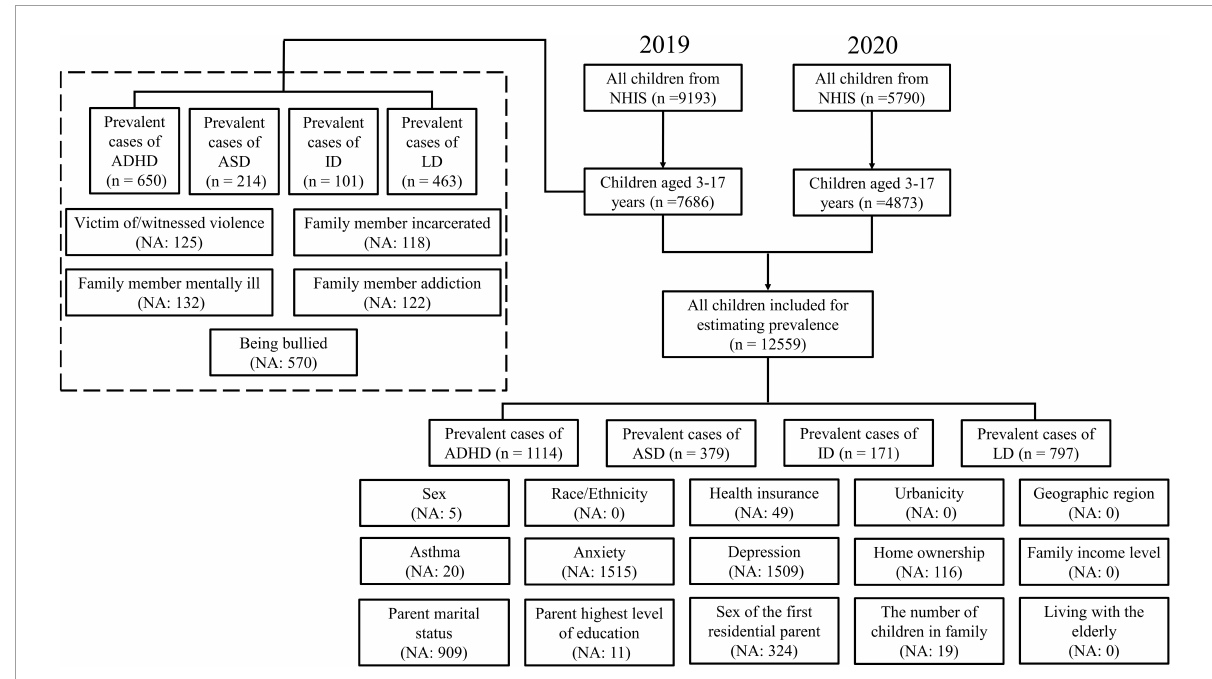
FIGURE1 A flowchart of children and adolescents included in the study and the number of missing values for each variable.